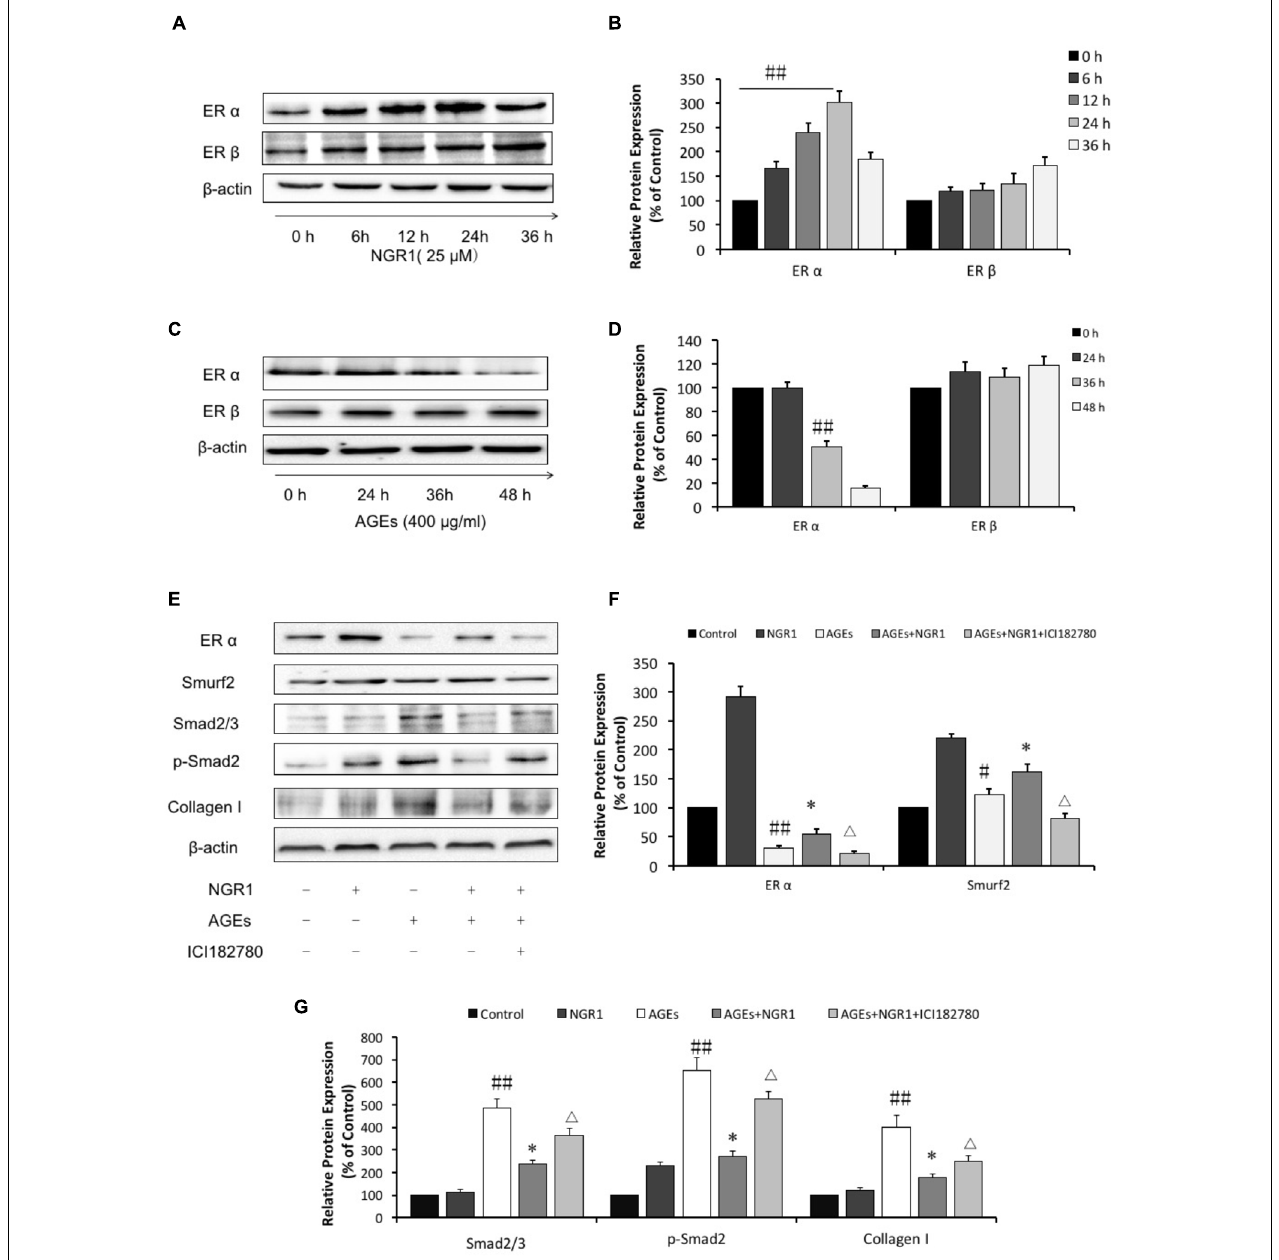
FIGURE 4 | NGR1 protects H9c2 cardiomyocytes from AGEs injury by promoting the estrogen receptor expression, which subsequently initiates Akt signaling and suppresses TGF β signaling. (A) The impact of NGR1 on ER protein expression. (B) The relative expression levels of ER α and ER β compared to β -actin are expressed in the bar graphs. (C) The impact of AGEs on ER protein expression. (D) The relative expression levels of ER α and ER β induced by AGEs compared to β -actin are expressed in the bar graphs. (E) H9c2 cells were pretreated with the ER inhibitor ICI182780 (1 µ M) for 1 h, then pretreated with NGR1 for 24 h, and were subsequently incubated with AGEs for 36 h. Immunoblotting analysis determined the expression of ER α , Smurf2, Smad2/3, p-Smad2, and Collagen I. (F) The relative expression levels of ER α and Smurf2 compared to β -actin are expressed in the bar graphs. (G) The relative expression levels of Smad2/3, p-Smad2 and Collagen I compared to β -actin are expressed in the bar graphs. The quantitative data are presented as the mean ± SD of three independent experiments. # P < 0.05 or ## P < 0.01 vs. the Control group or 0 h group, ∗ P < 0.05 vs. the AGEs group, (cid:49) P < 0.05 vs. the AGEs + NGR1 group.